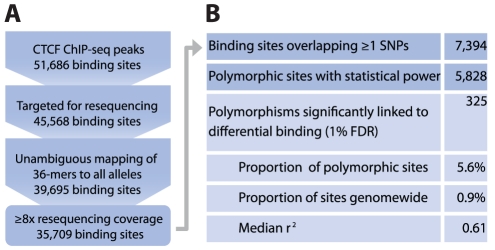
Genome-wide survey of the effect of genetic variation.(A) Filtering strategy for testable CTCF binding sites. A number of binding sites were excluded from the analysis due to microarray probe design constraints, poor mappability, differing mappability between two alleles, or insufficient resequencing coverage. (B) Summary of the prevalence of SNPs that affect CTCF occupancy at an FDR of 1%. Some sites overlapping SNPs were excluded for having insufficient data points per genotype to perform a robust regression. The model explained a substantial amount of the variance at significant sites (median r2 of 0.61).